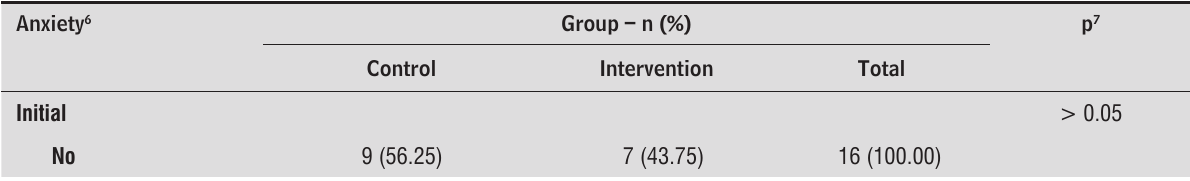
Table 4 - Distribution of occurrence (n) of anxiety in percentages according groups (to Anxiety 6 Group – n ( % ) p 7 Control Intervention Total Initial > 0.05